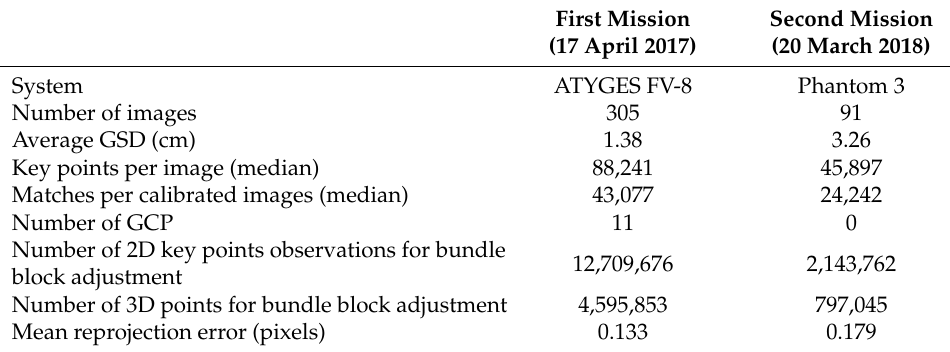
Table 1. Processing results obtained with Pix4D